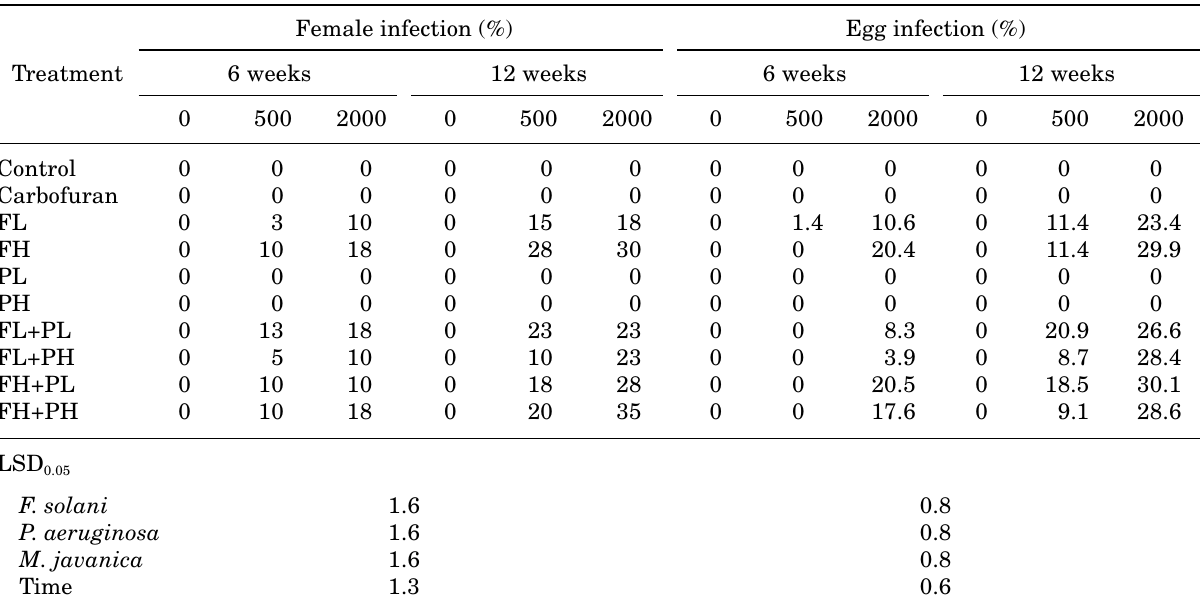
Table 4 . Fusarium solani infection in Meloidogyne javanica females and eggs extracted from tomato roots 6 or 12 weeks after inoculation with 500 or 2000 M. javanica juveniles per pot and treated with F. solani at rates of 10 6 (FL) or 10 7 (FH) cfu ml -1 suspension, or with Pseudomonas aeruginosa at rates of 10 7 (PL) or 10 8 (PH) cfu ml -1 suspension, with combinations of the two (FL+PL; FL+PH; FH+PL; FH +PH), or left untreated